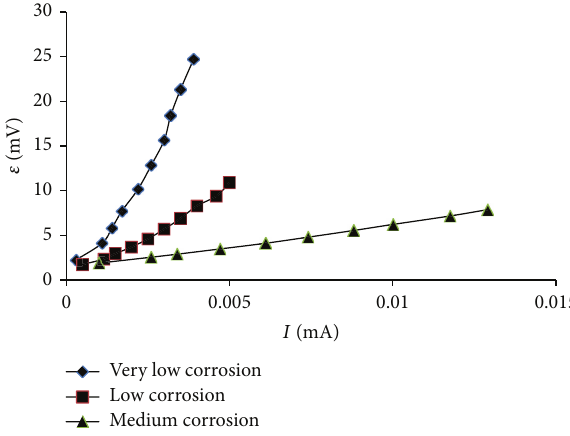
Figure 8: Polarization curves for specimens with very low, low, and medium corrosion.